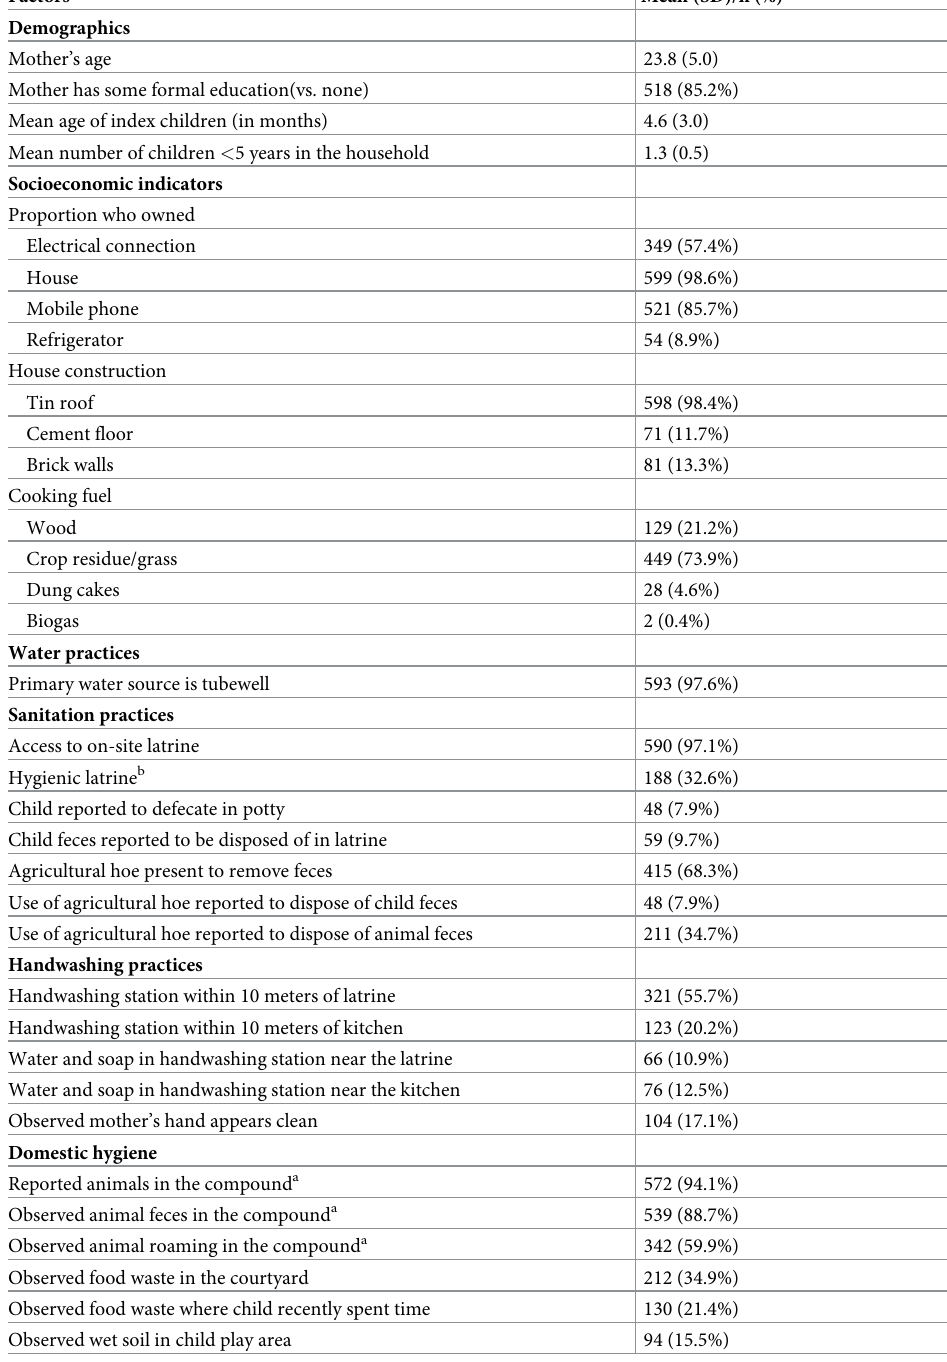
Table 1. Demographic and household characteristics of study participants (N =